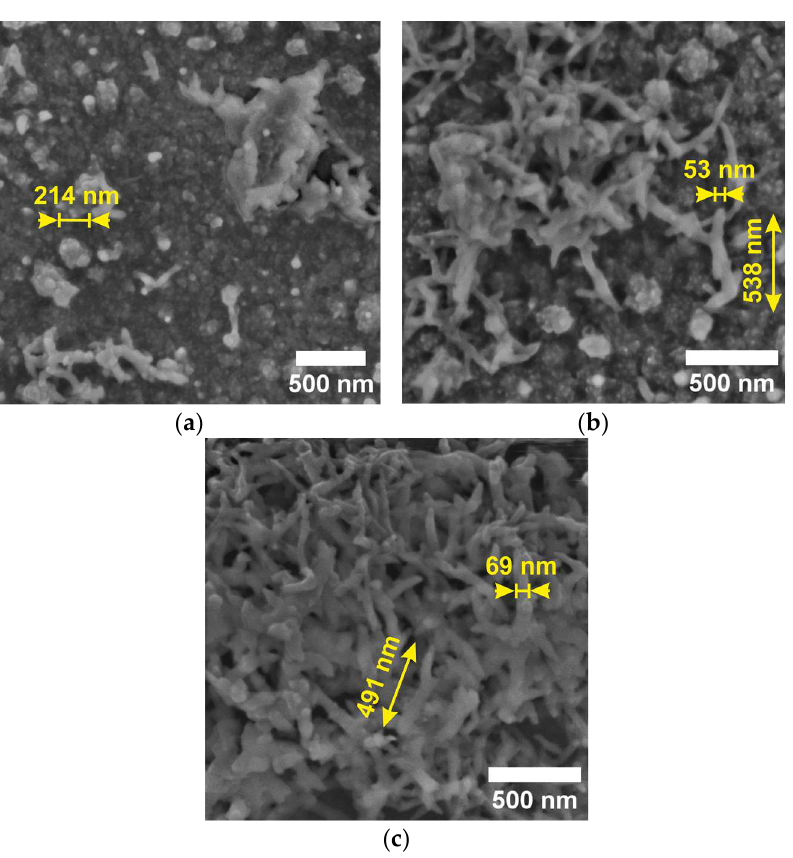
Figure 6. SEM micrographs of the deposited active layers surface morphology polymerized in: ( a ) aqueous solution, ( b ) sulfuric acid, and ( c ) acetic acid.